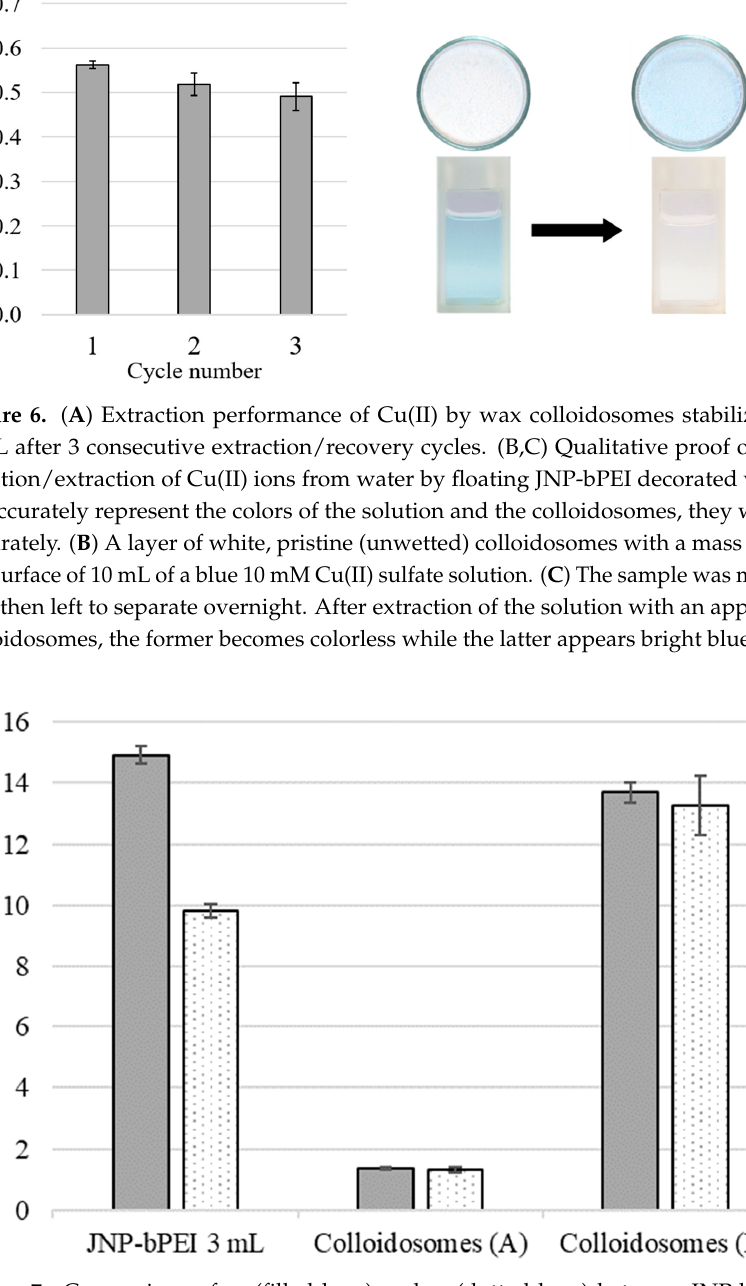
Figure 7. Comparison of q e (filled bars) and q r (dotted bars) between JNP-bPEI 3 mL and the colloi- dosomes that were prepared with it. q of Colloidosomes ( A ) was calculated using the total mass of the colloidosomes. q of Colloidosomes ( B ) was calculated using the approx. mass of JNP-bPEI in the